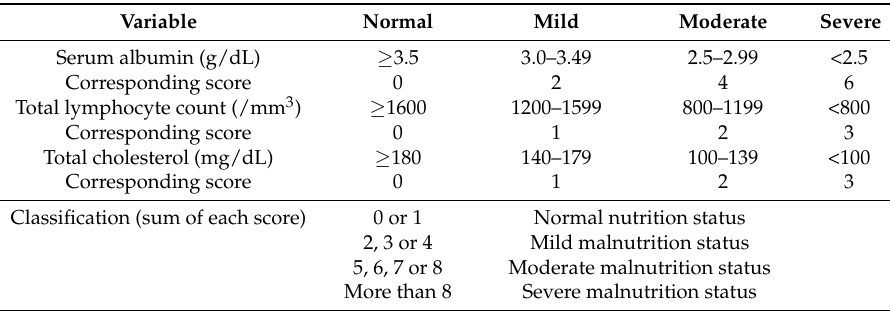
Table 1. Controlling Nutritional Status (CONUT)